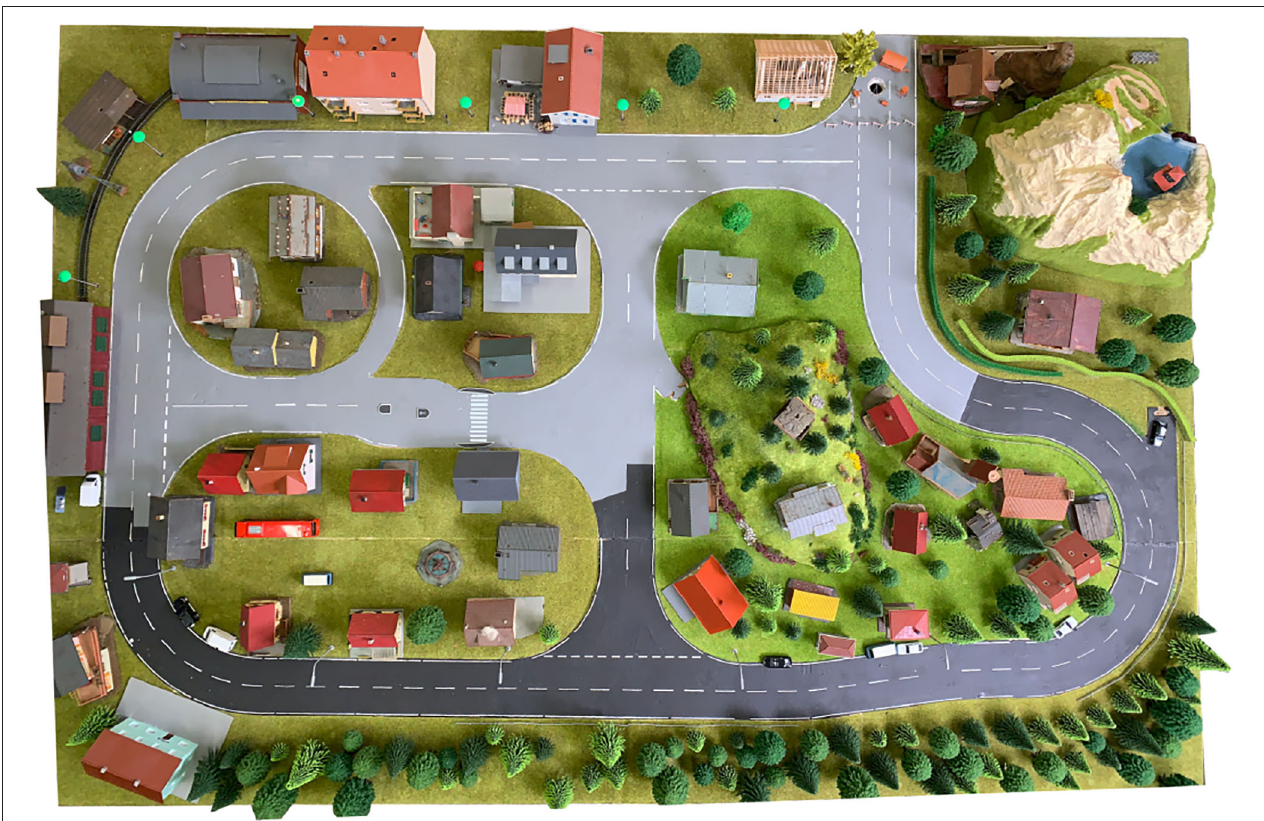
FIGURE 1 | Bird’s view of the small test area. Houses, trees, etc. are held with magnets to be easily movable. The image shows a typical placement of these objects as it was used for the first tests. Roadway surfaces and road markings have intentionally varying colors and quality.